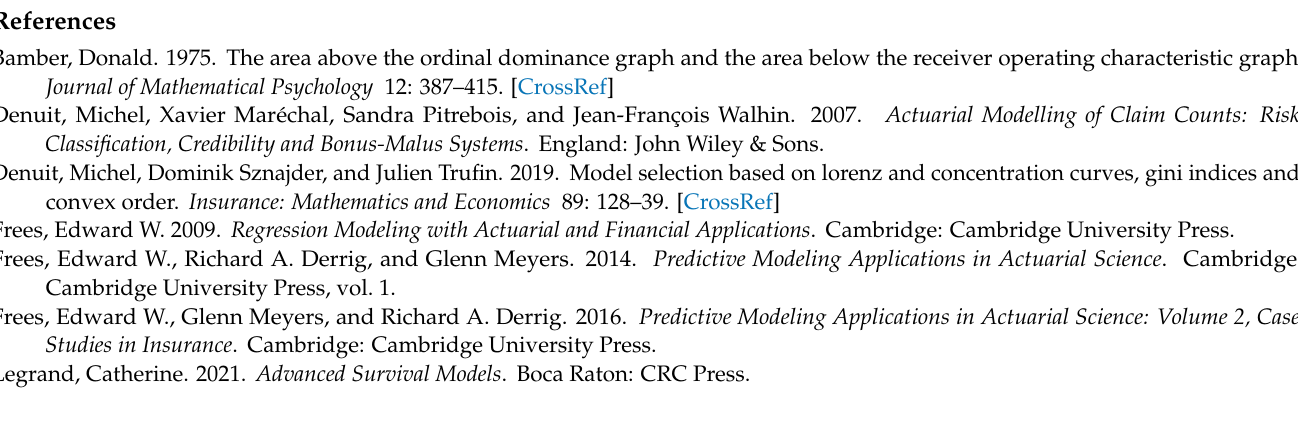
Figure A4. Weighted-mean-plot for ˆC pricing game. It is obtained by using the number of clusters that resulted in the lowest